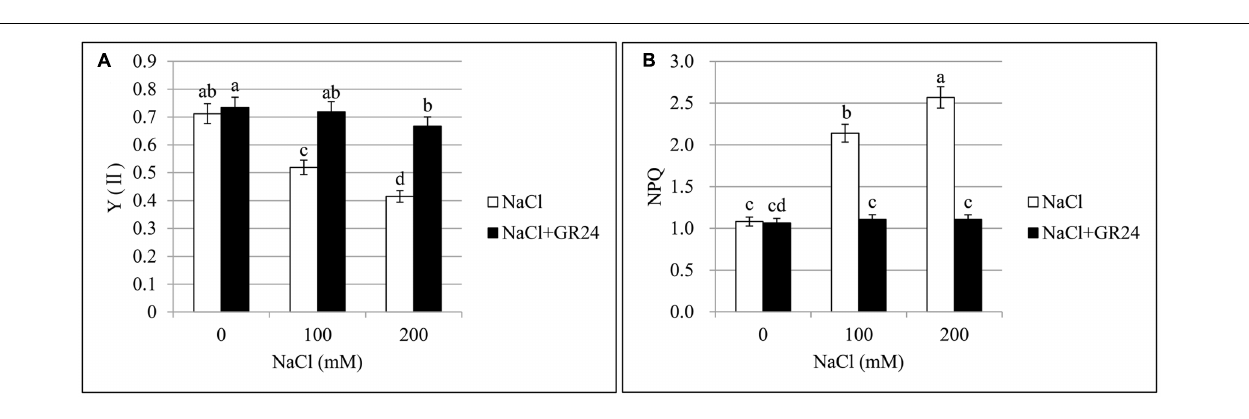
FIGURE 3 | Effects of GR24 and salinity stress on the chlorophyll fluorescence from leaves in B. napus cv. ZS 11. Quantum yield of PSII (Y(II)) (A) and non-photochemical quenching (NPQ) coefficient (B) at 7 days in the presence of GR24 (0.18 µ M) and salinity (0, 100, and 200 mM NaCl, respectively) in ZS 11 ( n = 6). All experiments were repeated three times and the data represent means ± SE. Means followed by same small letters are not significantly different by the LSD test at P ≤ 0.05